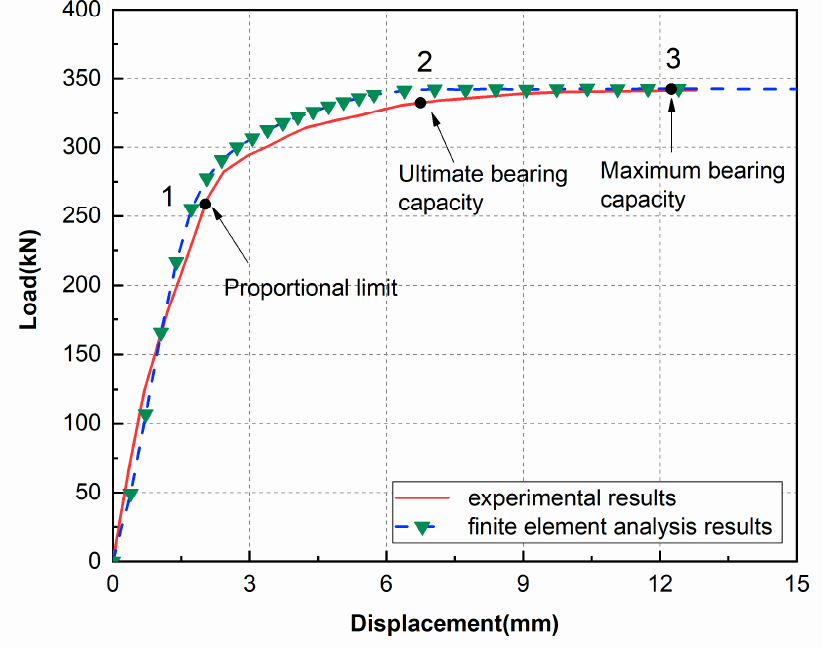
Figure 19. Comparison of load–displacement curves between FEM and test results.